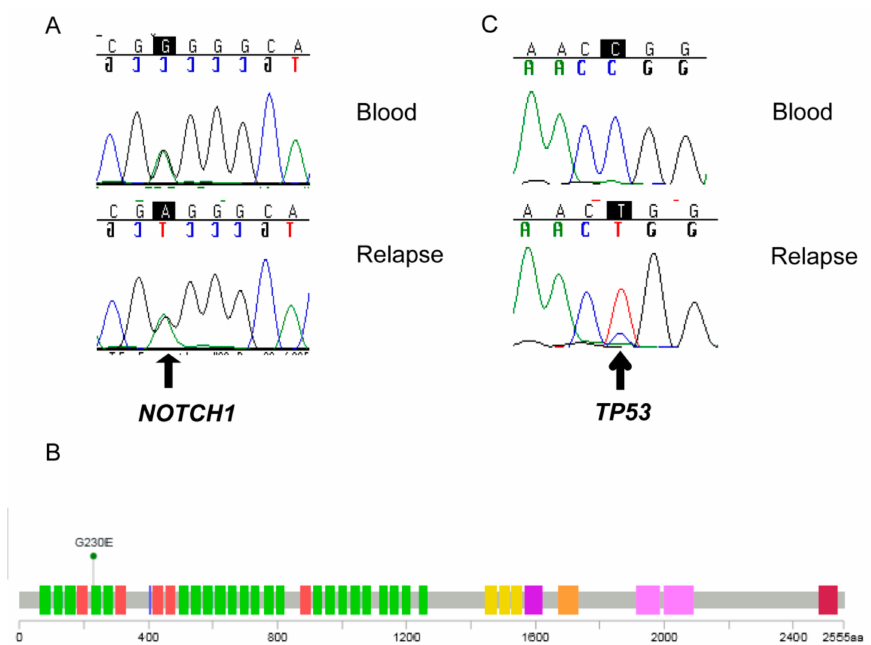
Figure 4. Detection of a notch receptor 1 ( NOTCH1 ) germline mutation and a tumor protein P53 ( TP53 ) somatic mutation. Sanger sequencing of the genomic DNA extracted from the blood and the relapse (no 225) was done with primers specific for the NOTCH1 ( A ) and the TP53 ( C ) mutation identified by RNA-seq. The arrow indicates the (NM_017617.3:c.689G > A) mutation rs121912651. The arrowhead indicates the rs121912651. ( B ) Structure of NOTCH1 as reported in cBioportal. The position of the Gly230Glu mutation is indicated. Green: EGF-like domains; Red: Calcium-binding EGF domains; Yellow: LNR Domain; Purple: NOD (NOTCH protein domain); Orange: NODP (NOTCH protein domain); Rose: Ankyrin repeats; Dark red: unknown